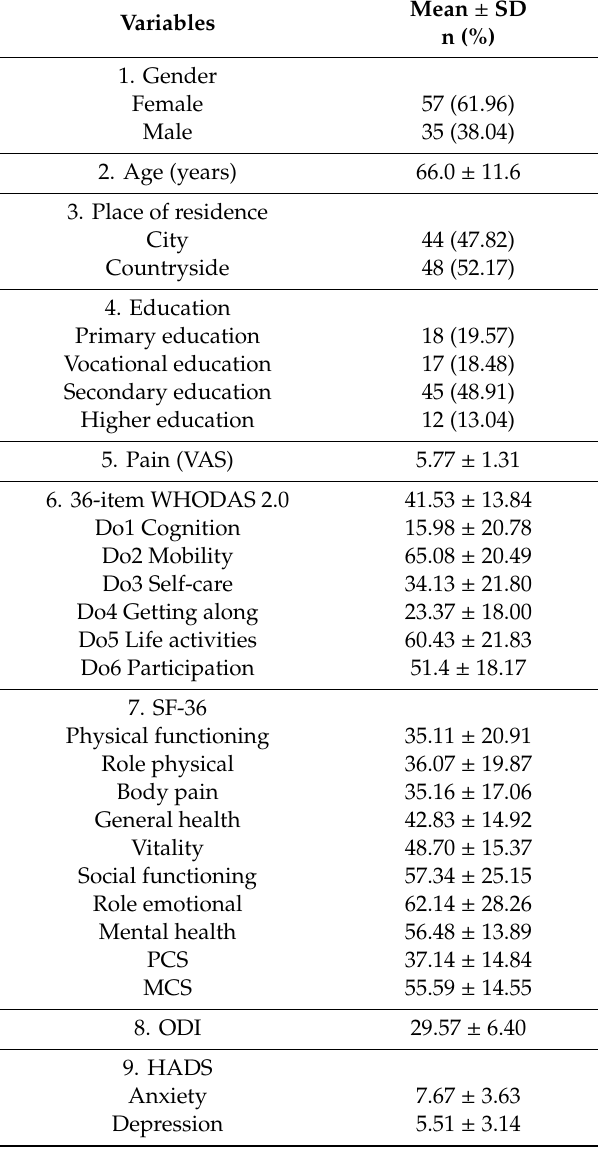
Table 1. General socio-demographic characteristics of the study population (n =